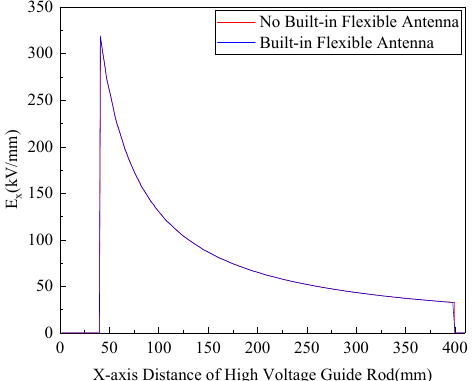
Figure 14. Field strength change in the x-axis 0~400 mm.